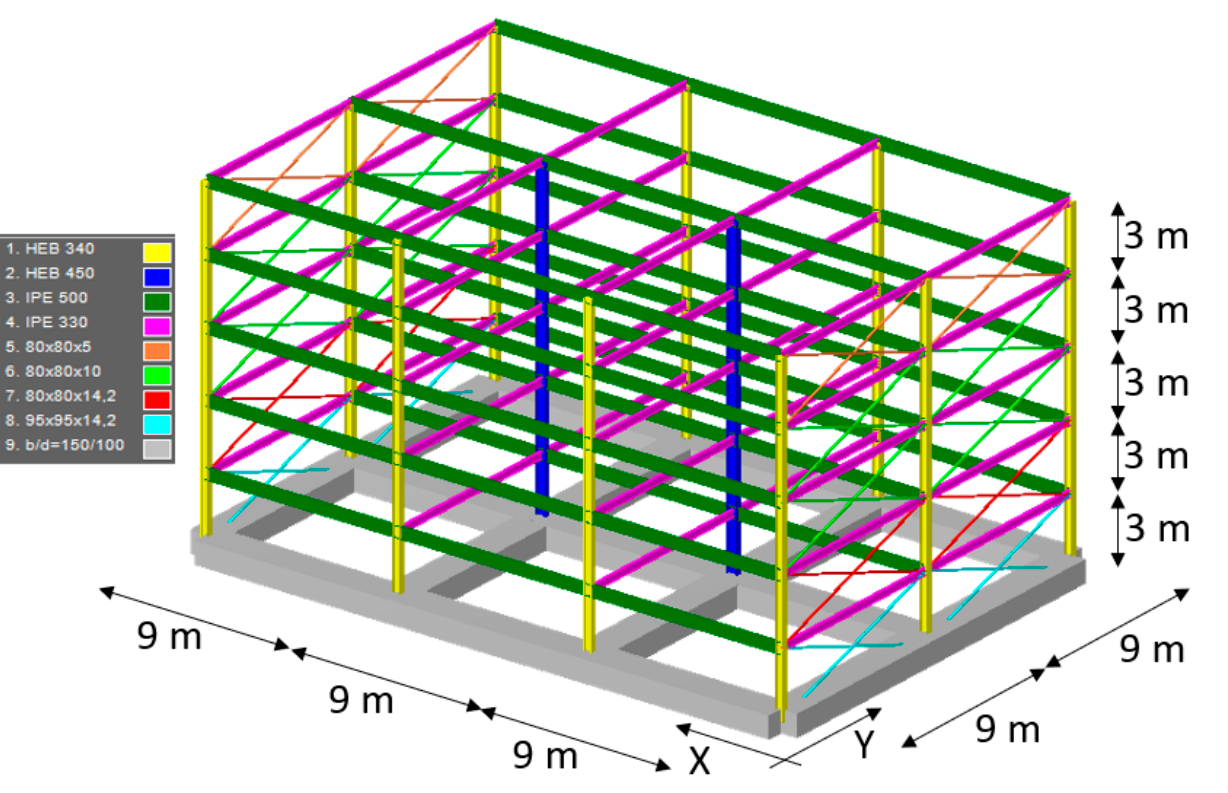
Figure 9. Analysed steel frame building.